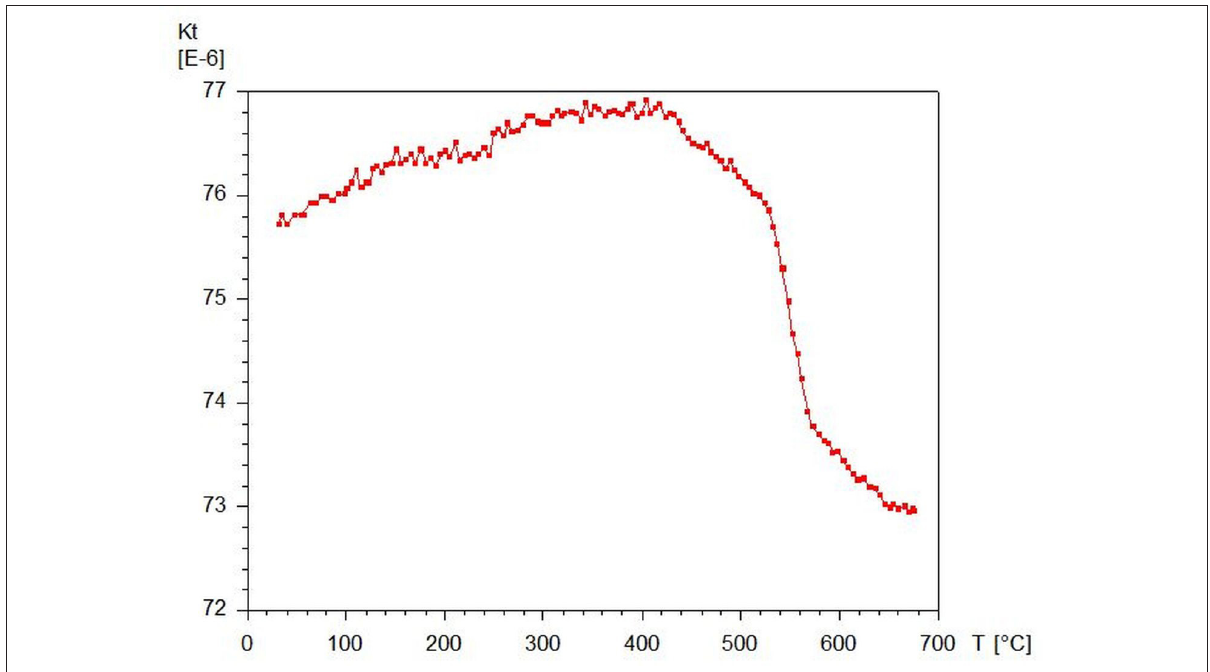
Thermomagnetic curve showing the variation of magnetic susceptibility with temperature for sample